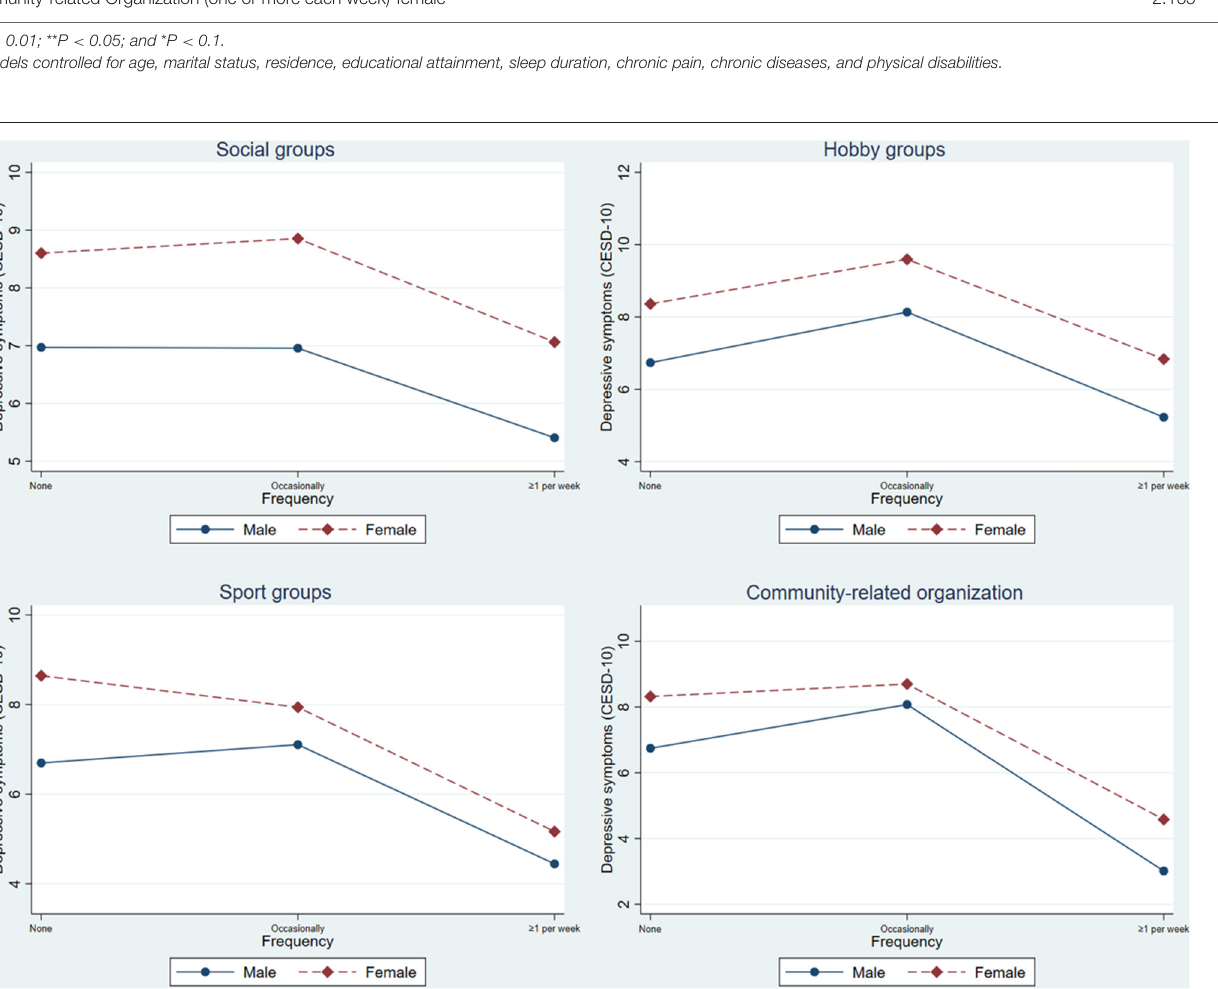
Frontiers in Psychiatry |